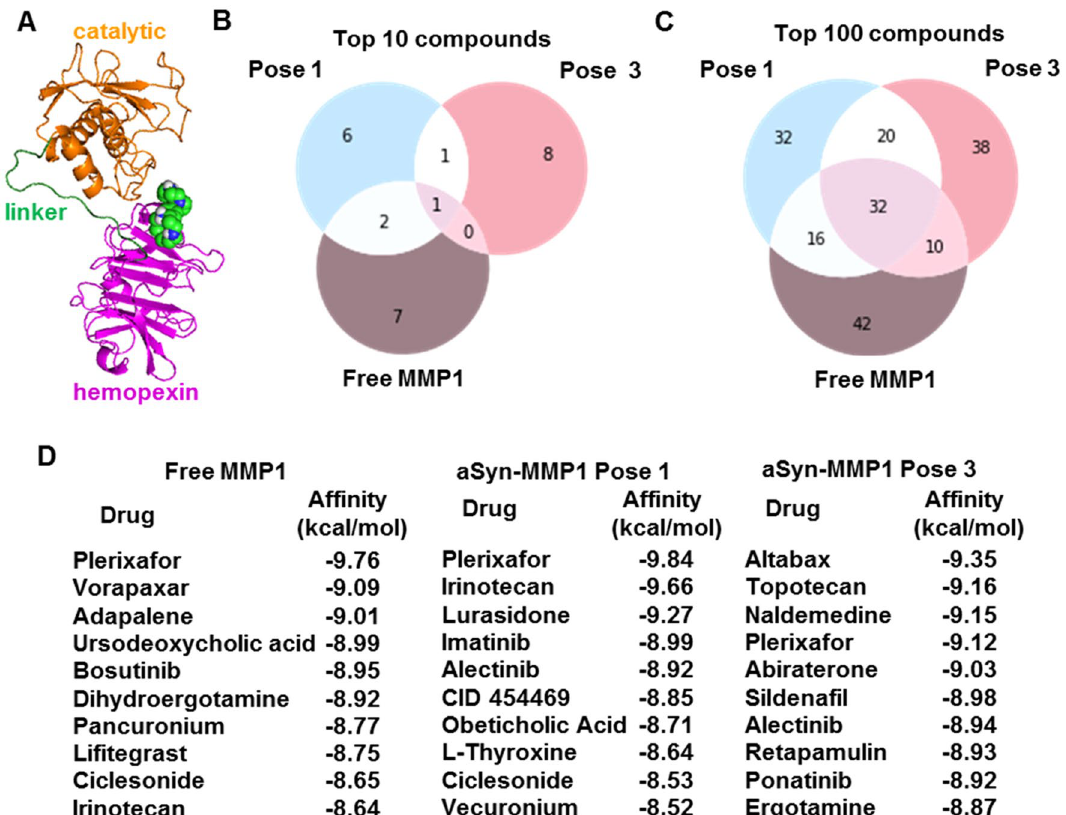
Figure 7. Substrate- and pose-dependent virtual screening against MMP1. ( A ) MMP1 bound to Plerixafor (green and blue spheres), the top hit against free MMP1. We performed virtual screening against the same site for free MMP1, pose 1, and pose 3. ( B,C ) Venn diagrams of top 10 and 100 molecules show unique and common ligands. ( D ) Identities and affinities for the top 10 molecules. For docking parameters, see supplementary